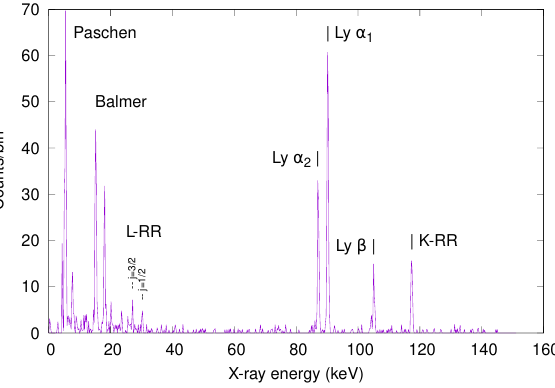
Figure 4. X-ray spectrum for Pb 82 + + e − → Pb 81 + + h ν measured with a Ge(i) detector at the 0° window and in coincidence with particle detection at detector position ‘B’ as indicated in Figure 3. A detailed analysis of the X-ray spectra in forward and backward directions is given in